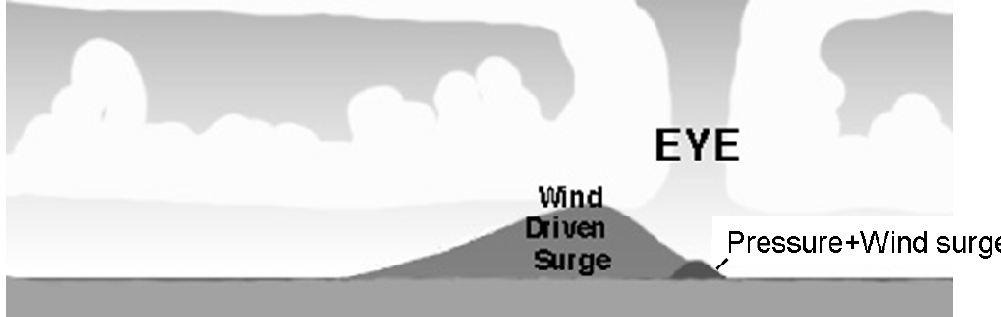
Figure 1 . Localization of the storm surge